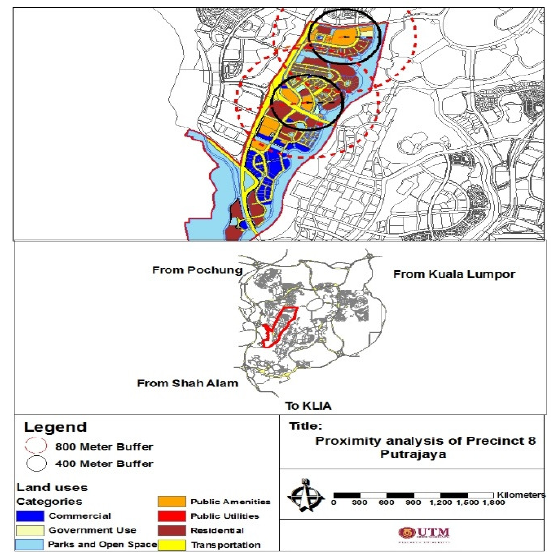
Fig. 5: 400m and 800m radius exploring proximity of Lower Walkability Precinct